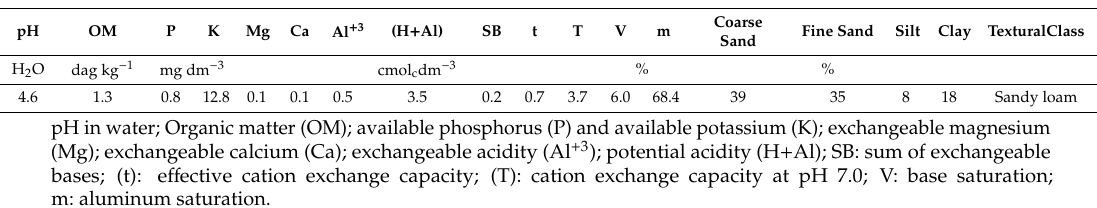
Table 1. Chemical and physical characteristics of the soil in the 0–40 cm